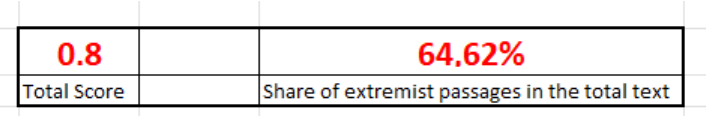
Figure 5. Example of a result provided by the tool when scoring